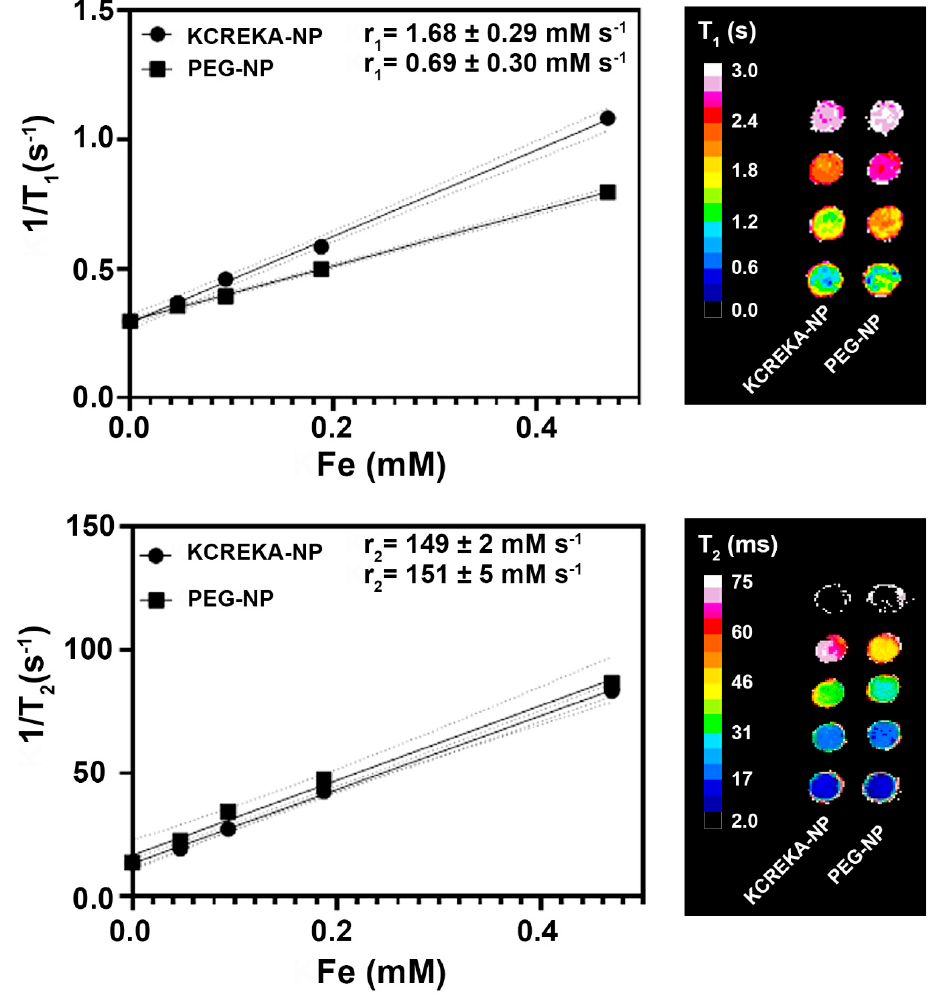
Figure 2. T 1 and T 2 map plots vs. Fe concentrations for the calculation of the r 1 and r 2 relaxivities of KCREKA-NPs and PEG-NPs. Right images show representations of the phantom for both T 1 and T 2 maps. Table 1. Physicochemical properties of KCREKA-NPs and